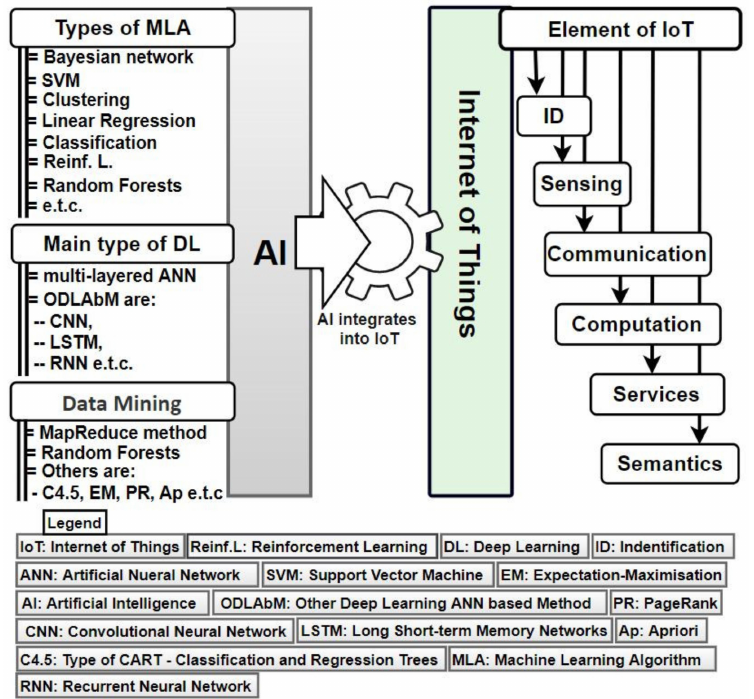
Figure 6. Showing IoT characteristics (i.e., role) that integrate AI by way of being helped to take the management responsibility in